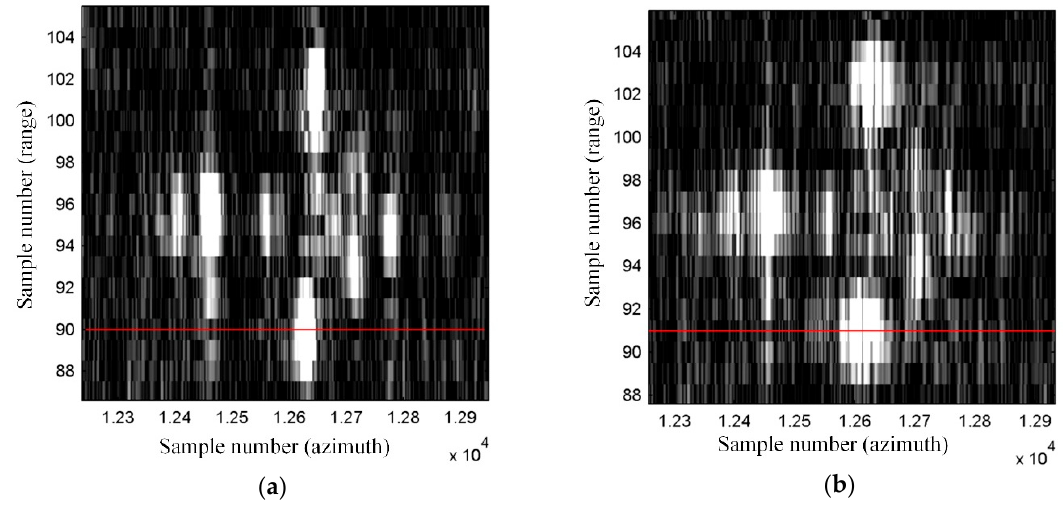
Figure 11. Image of the arrow made of corner reflectors: ( a ) with the INS-based motion compensation (MOCO), ( b ) with the INS / GPS-based MOCO; red line—an analyzed row.